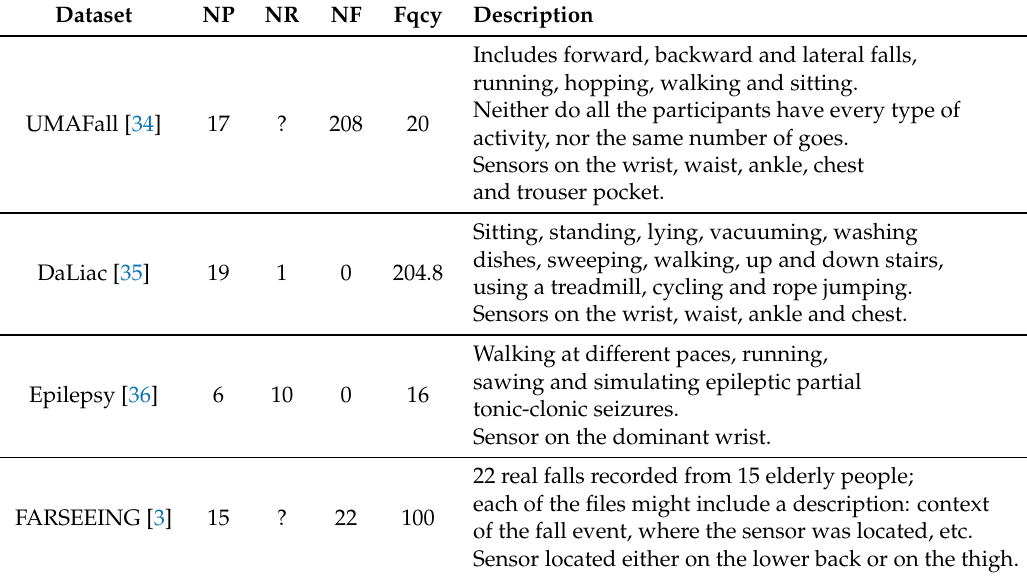
Table 1. Descriptions of the different datasets used in this research. Columns NP, NF and NR stand for the Number of Participants, the Number of Falls in the dataset and the Number of goes for each ADL, respectively. A question mark (?) means that it is not a regular value. The sampling frequency used in gathering the dataset is stated in Hz in the frequency column